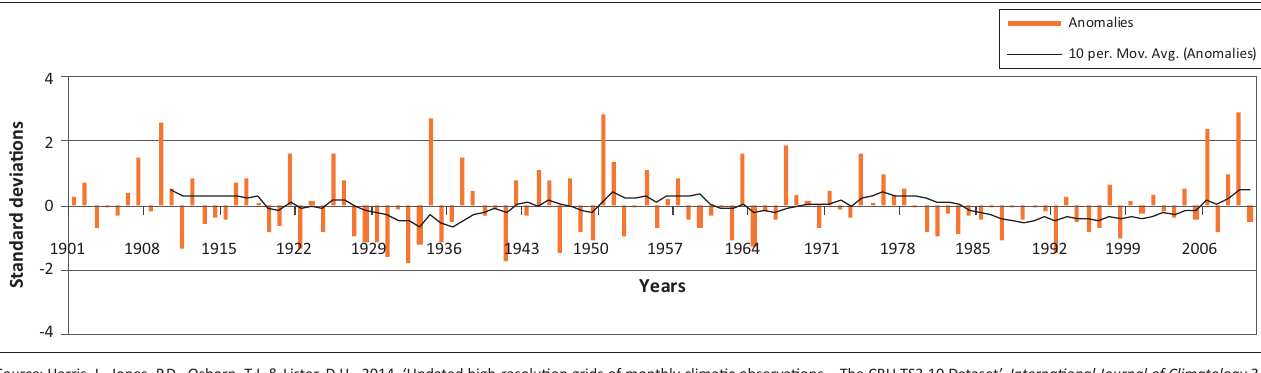
For the first decade (1940–1950) eight flood disaster